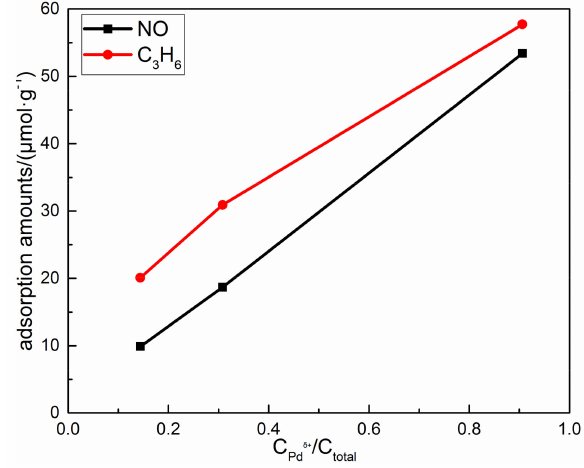
Figure 9. The relationship of NO and C 3 H 6 adsorption amounts and the amount of dispersed Pd ions.